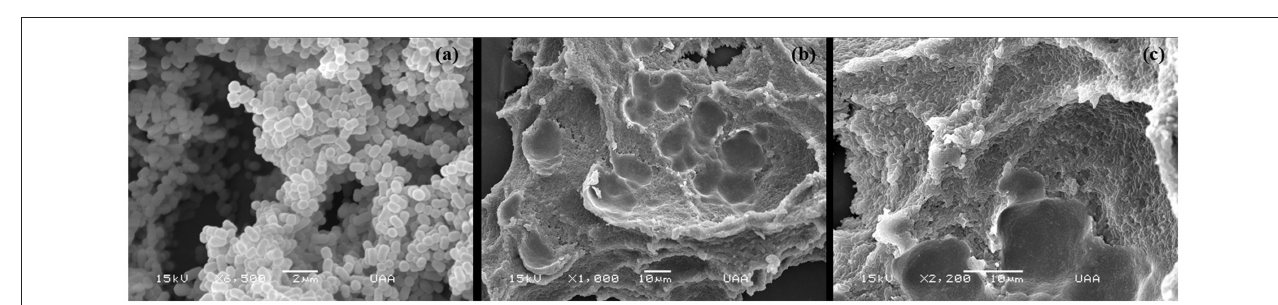
FIGURE 5 | Scanning electron microscopy (SEM) of biofilms produced by positive samples to A. pleuropneumoniae from drinking water in swine farms. (a) Biofilms of A. pleuropneumoniae 4074. (b,c) Biofilms of positive samples to A. pleuropneumoniae from drinking water collected at swine farms.